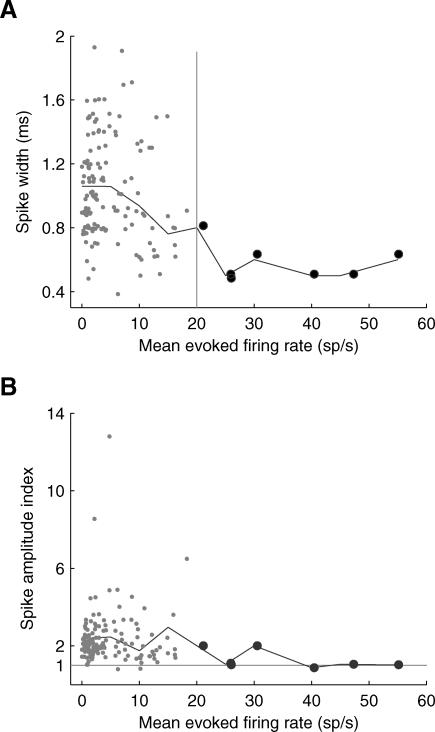
Very Responsive Neurons Might Be Narrow-Spiking InterneuronsNeurons with higher evoked firing rates tended to have narrow, symmetrical spikes.(A) Spike width decreased with increasing evoked firing rate (n = 144 neurons).(B) Neurons with higher mean evoked firing rates displayed more symmetrical spikes. Perfectly symmetrical spikes would fall on the gray horizontal line. The large dots in both panels denote cells with mean evoked firing rates >20 sp/s. The black lines in both panels indicate average values in 5 sp/s bins. The mean evoked firing rate for each cell was computed as the mean firing rate across all response bins. In (A) all points were jittered slightly so that overlying points could be seen. One cell had a very large spike amplitude index of 34.3 (spike width 1.9 ms, mean evoked firing rate 1.3 sp/s) and was excluded from both panels. Note that due to lowpass filtering of the traces recorded with glass electrodes, spike widths may appear wider than when recorded using conventional metal extracellular electrodes.